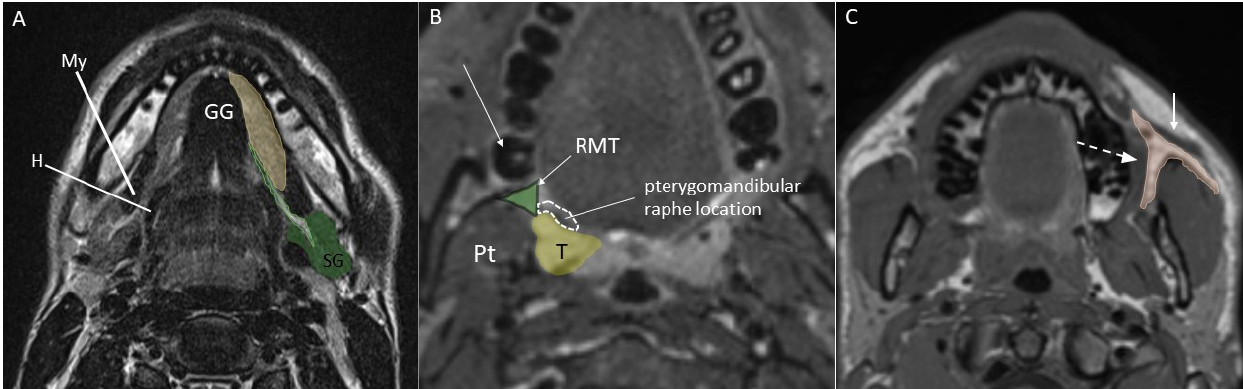
Figure 2. Anatomy of the oral cavity. ( A ) Axial T2 image of the floor of the mouth. Genioglossus (GG), mylohyoid (My), hyoglossus (H) muscles, with the sublingual gland (orange), deep portion of submandibular gland (SG, dark green), and Wharton’s duct (light green). ( B ) Axial T2 fat-saturated image showing the retromolar trigone (RMT, green). It is a triangular area of mucosa between the lower jaw third molar (white arrow) and the palatine tonsil (T, yellow). The pterygomandibular raphe location, between the anterior tonsillar pillar and the retromolar trigone is also highlighted. Pt: medial pterygoid muscle. ( C ) Axial T1 image showing the buccal space (pink). It is a fat-containing subsite located between the buccinator (dotted arrow) and platysma (arrow) muscles.